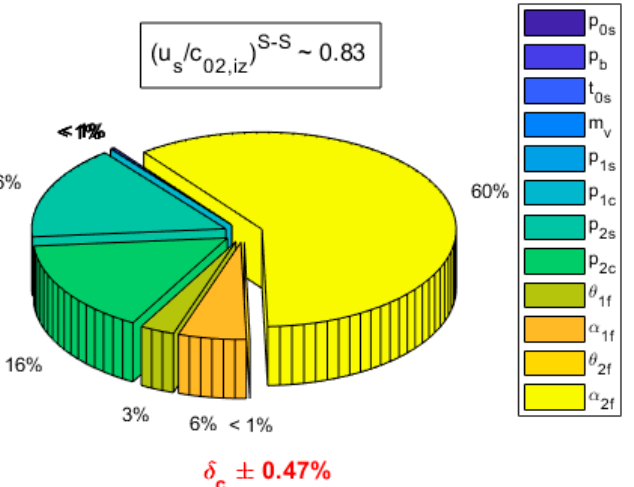
Figure 15. Bucket loss coefficient partial uncertainties diagram for operating mode ( u / c ∼ 0.83 ) at the mean radius.